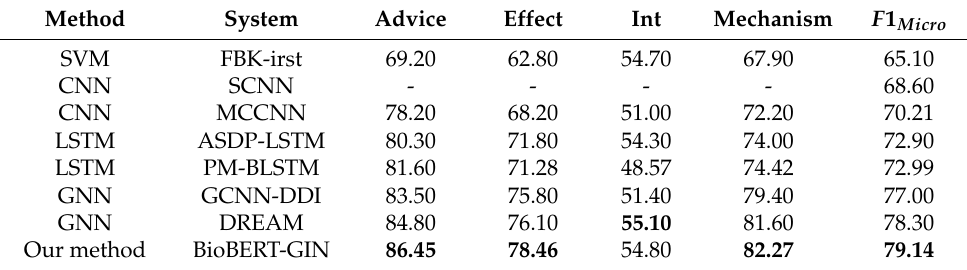
Table 2. Overall performance comparison of our proposed method. All values are F 1 scores (%) and ‘-’ denotes the value was not provided in the published paper. F 1 micro denotes the overall score on the four positive classes. The highest values are shown in